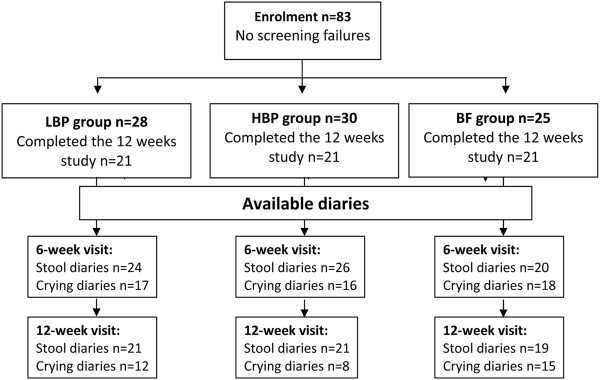
Participant flow diagram.